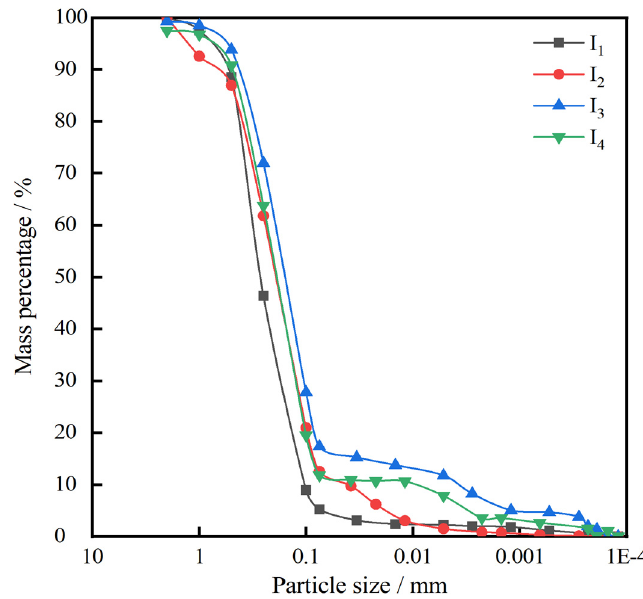
Figure 2. Ore drawing mouth 1.